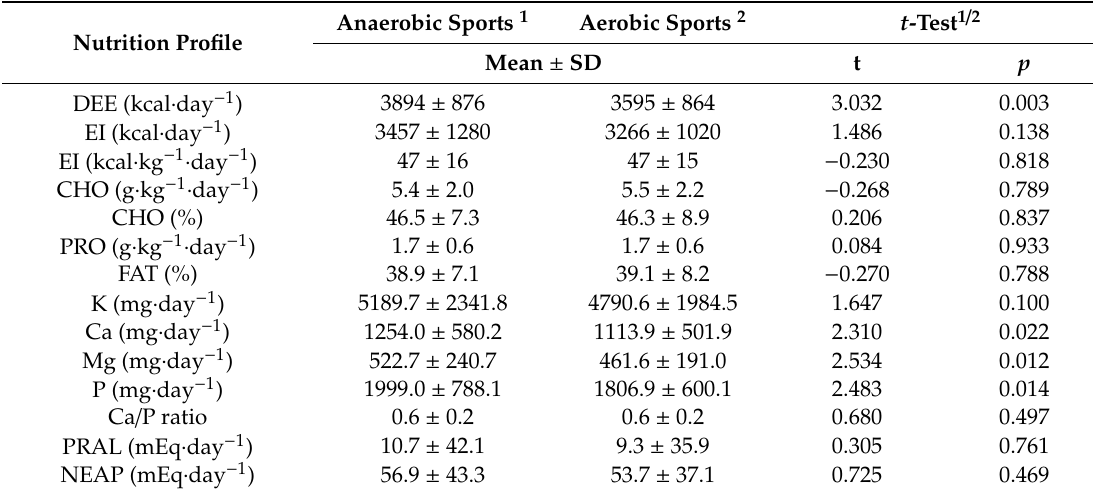
Table 3. Dietary intake of